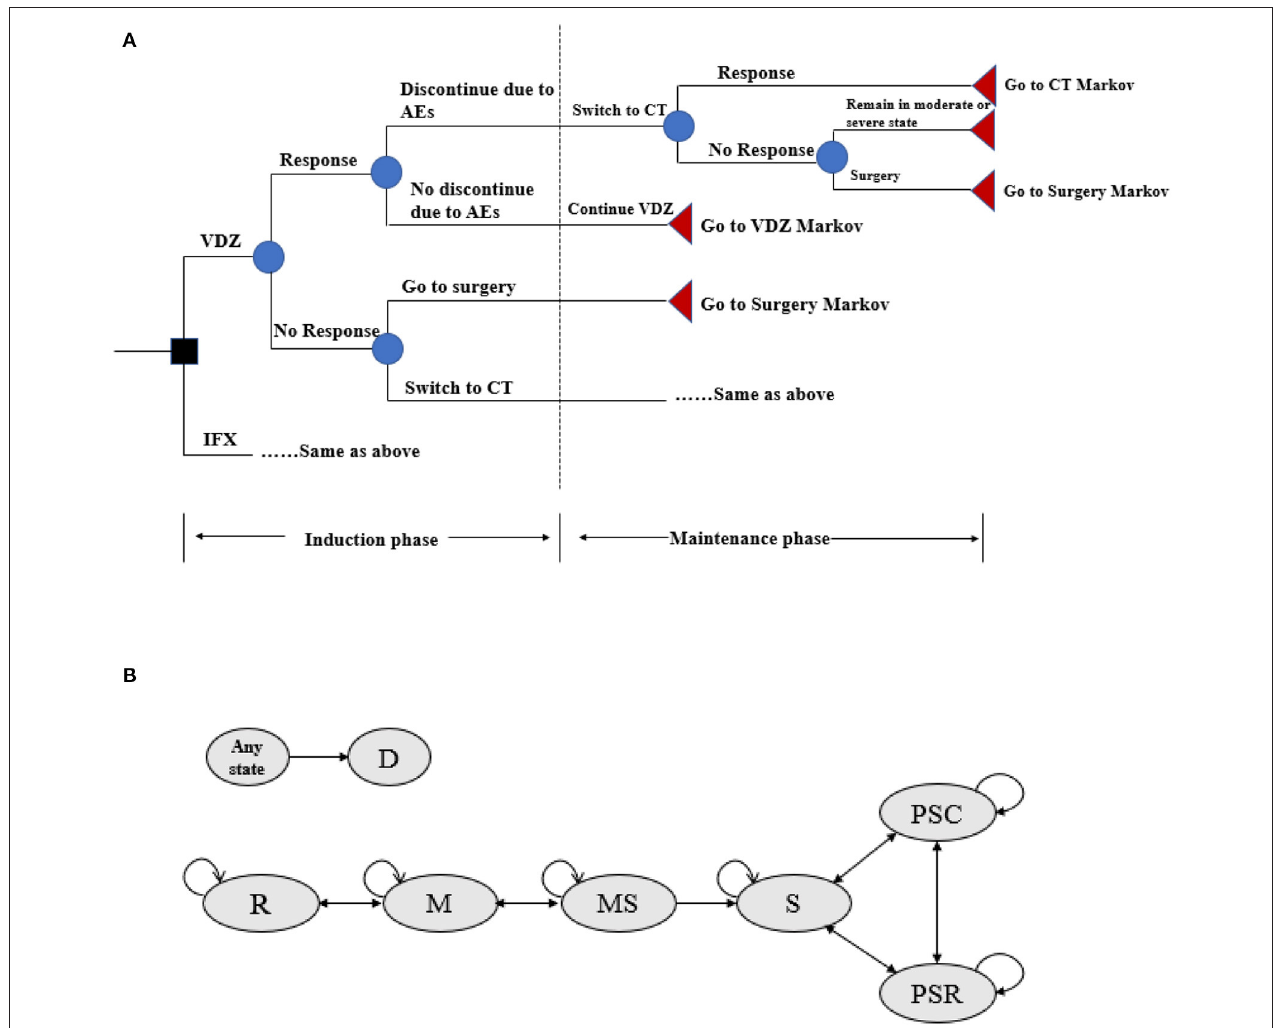
FIGURE 1 | (A) Decision tree model structure for VDZ and IFX. AEs, adverse events; CT, conventional therapy; IFX, infliximab; VDZ, vedolizumab. Response defined as reduction in Mayo score by ≥ 3 or a remission Mayo score < 3. (B) Markov model structure of maintenance therapy. R, remission; M, mild;